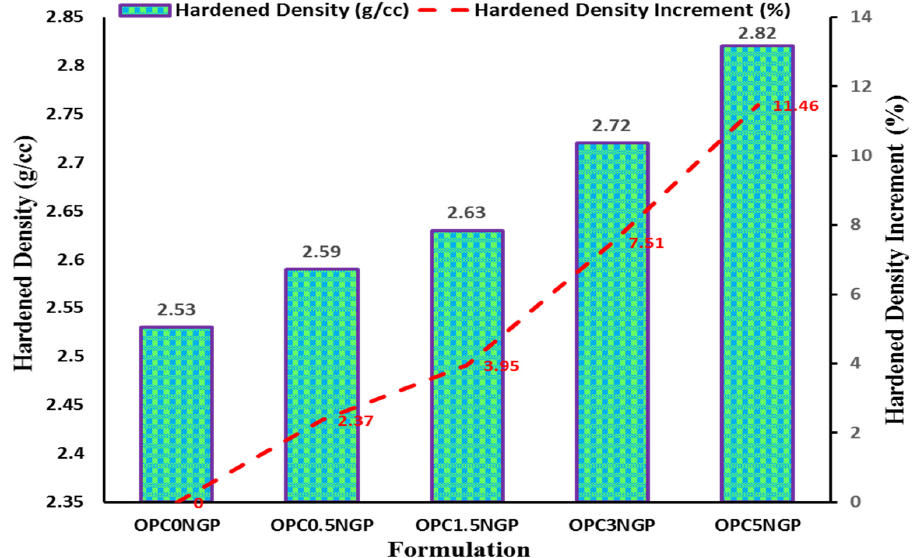
Figure 6. Hardened density (g/cc) and percentage increase in hardened